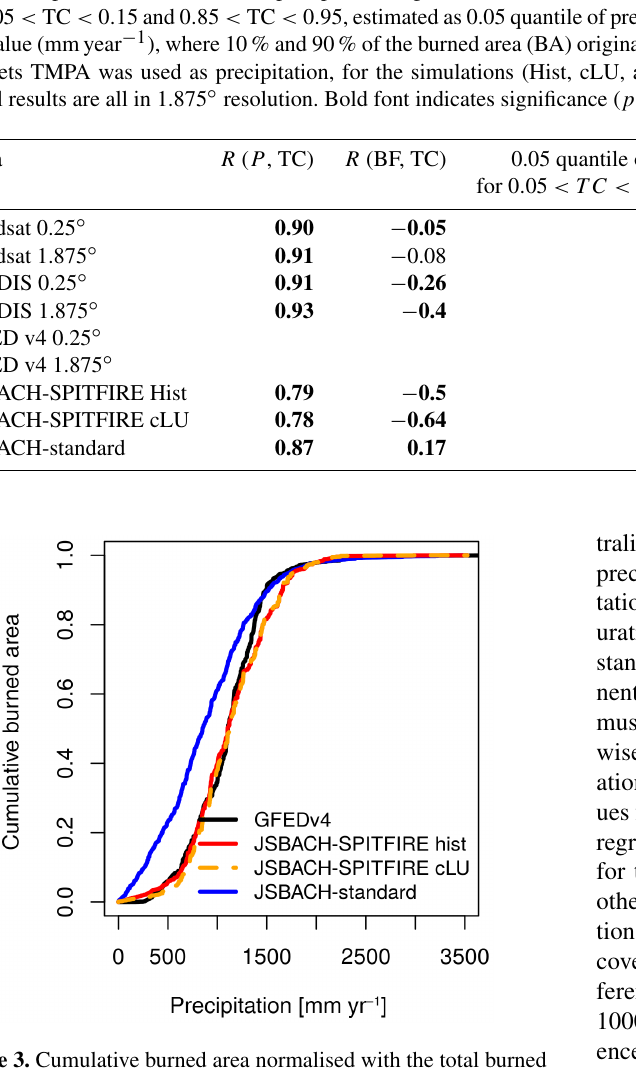
Figure 3. Cumulative burned area normalised with the total burned area for increasing precipitation. For the GFEDv4 burned area the TMPA data set was used; for the model simulations the MPI-ESM precipitation was